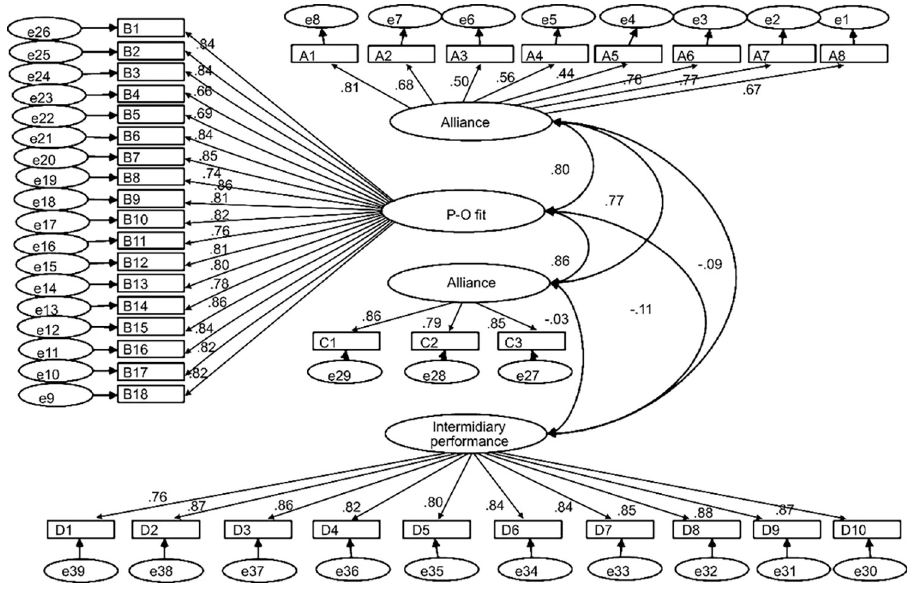
Fig 2. Diagram of model fit.